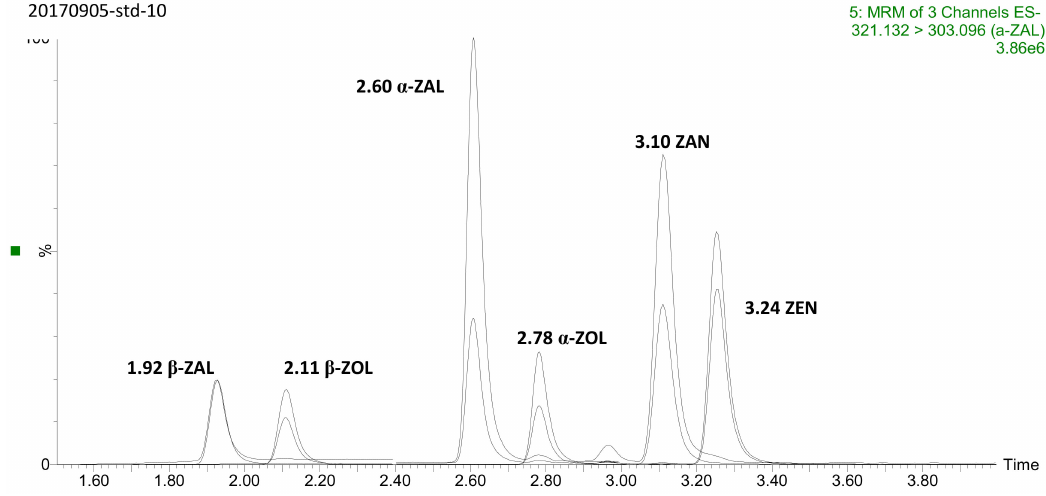
Figure 1. The overlaid chromatography of standard solution (10 ng mL -1 of each